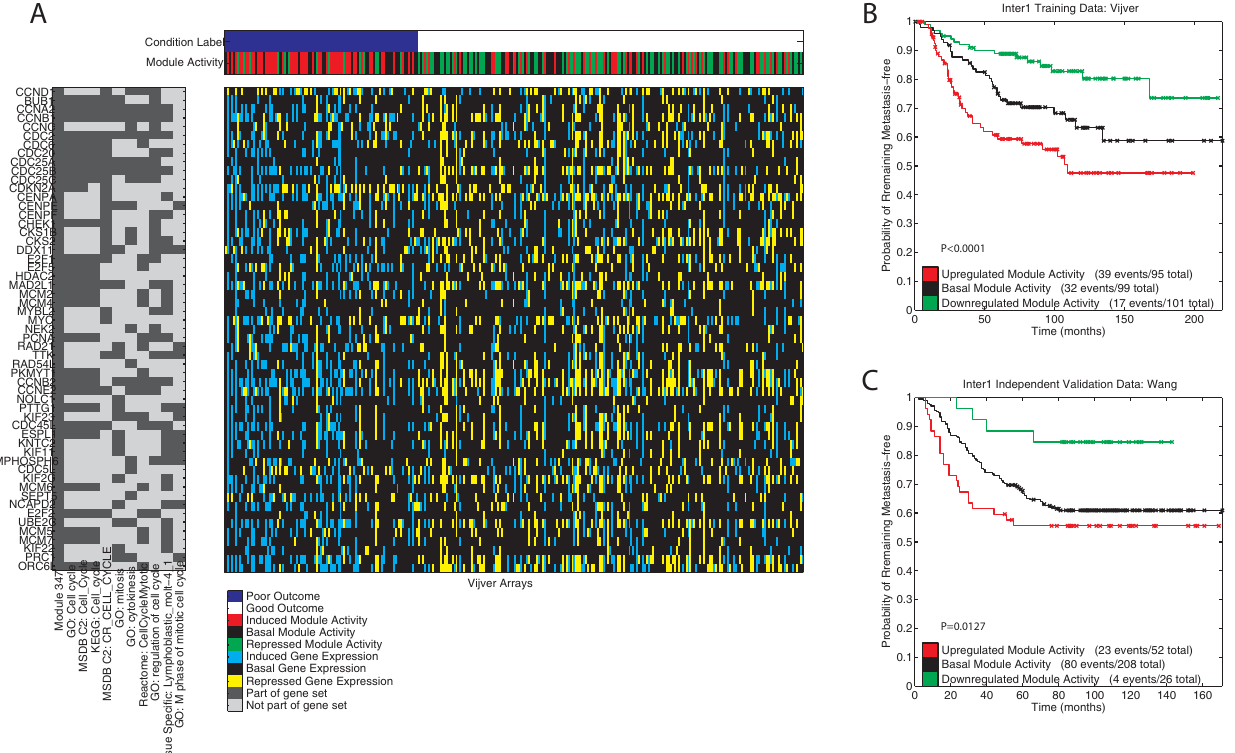
Figure 8. A cell cycle related module. A) Module activity data of a Cell Cycle related module (Module group 2 in Figure 7) that was extracted from the Vijver [21] data (Inter1, Table 1). The top heatmap shows the binary condition label, and the discrete module activity data (rows), for all the Vijver arrays (columns) [4]. Arrays are ordered according to the metastasis free survival time. The heatmap in the middle shows the discrete gene expression data for the 55 genes (rows) in the module. On the left, a binary heatmap shows the 55 genes, along with the gene sets that show the most significant overlap with this module. The gene sets are ranked based on their p-value for the overlap with the module (hypergeometric distribution), we show the top 10 gene sets (p-values ranging from 10 2 51 to 10 2 25 , all significant at p , 0.05 after Bonferroni correction). On the right, two Kaplan- Meier curves indicate the predictive power of this module when arrays with the same module activity are grouped. B) The Kaplan-Meier curves for the three groups defined by the activity of this module on the Vijver [21] data (Inter1 training, Table 1). C) The Kaplan-Meier curves for the three groups defined by the activity of this module on the independent [3] data (Inter1 test data, Table 1). The legend indicates the three groups and lists the number of events and total number within the groups. P-values correspond to the logrank test.